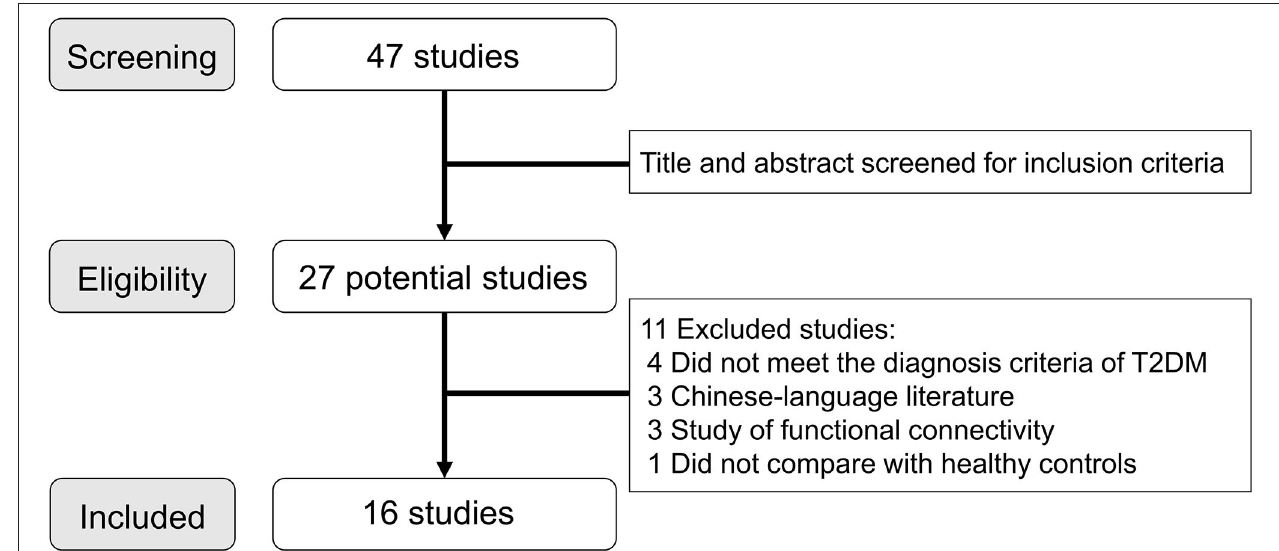
FIGURE 1 | Literature search and study selection flowchart. T2DM, type 2 diabetes